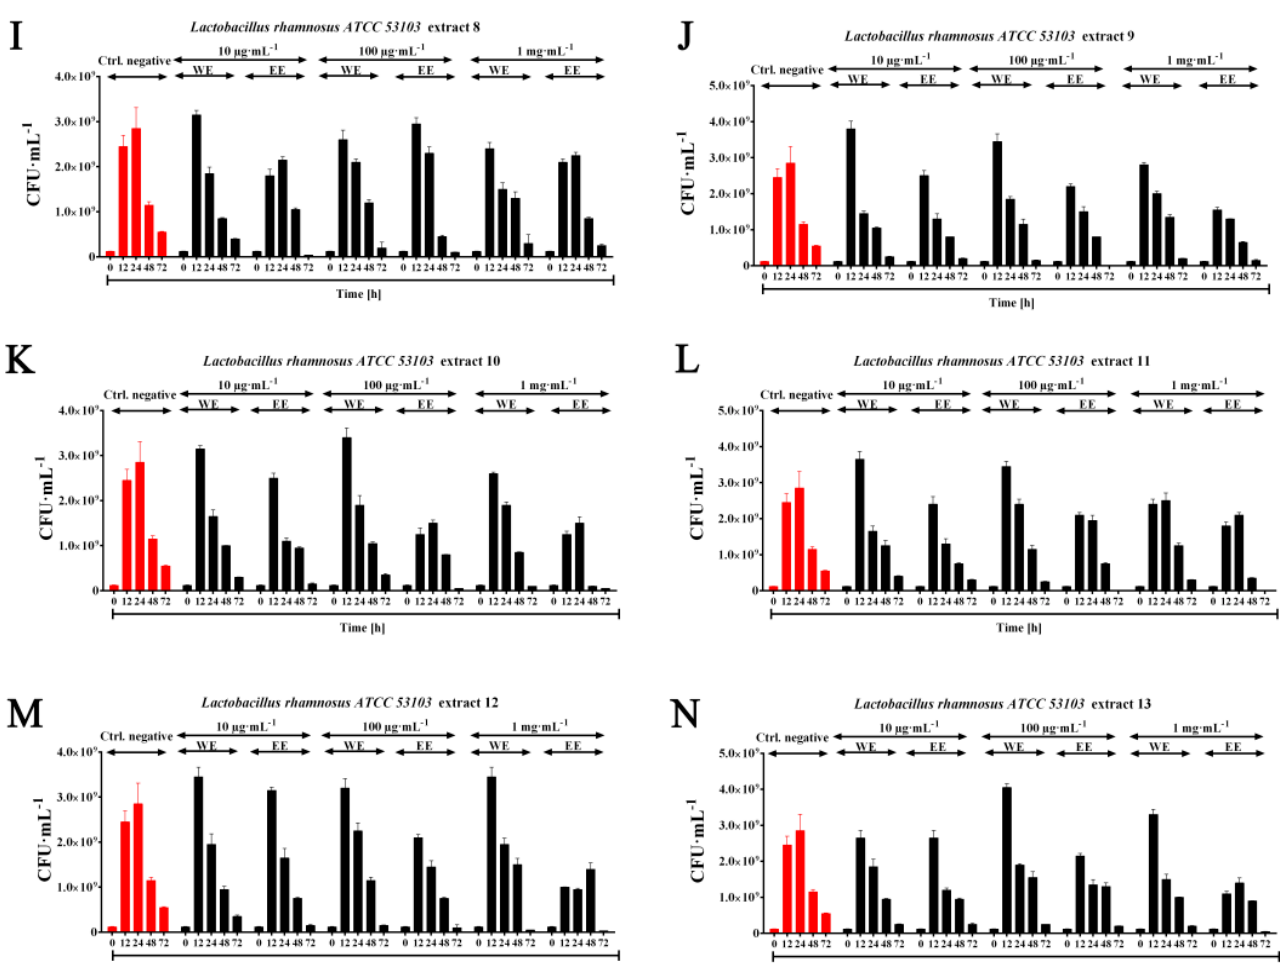
Figure 7. Stimulating effect of water and ethanolic extracts of algae (1–13, A – N ) on the growth of probiotic species Lactobacillus rhamnosus ATCC 53103 (CFU · mL − 1 ) after 12, 24, 48 and 72 h. MRS medium (without inulin addition) as a negative control and MRS medium with inulin addition with final concentrations—1 mg · mL − 1 , 100 µ g · mL − 1 , 10 µ g · mL − 1 —were used as positive control. For ethanol extracts, positive controls of appropriately diluted ethanol with final concentrations of—0.8%, 0.08%, 0.008% were also used.